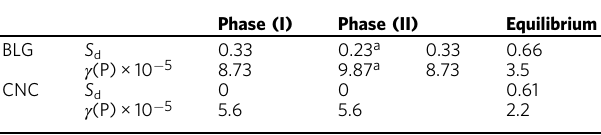
Table 2 Order parameter and rotational viscosity of para- nematic